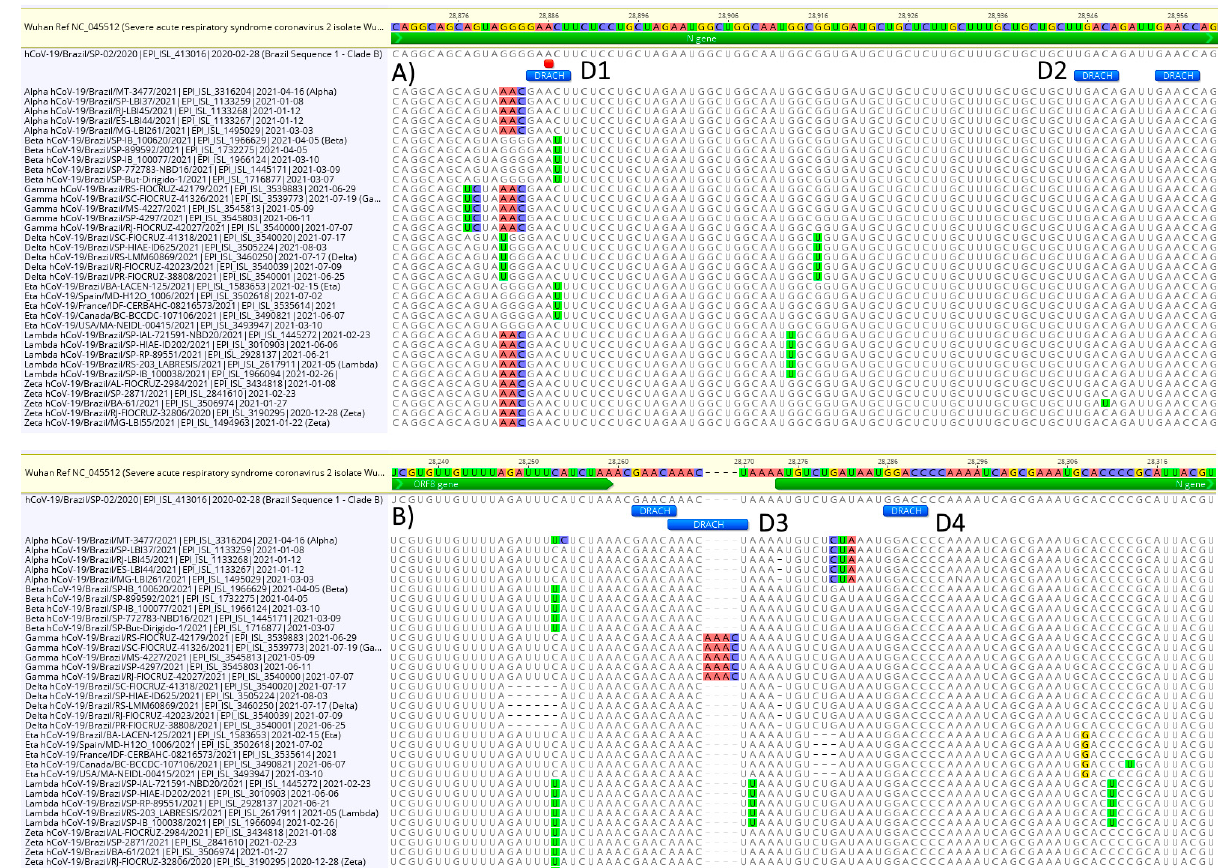
Figure 2. Variability of DRACH sequences among SARS-CoV-2 variants. In ( A ), the C > U change at 28,886 disrupts the m6A (marked red) DRACH motif (D1) in five variant Beta sequences and four variant Eta sequences, while a single variant Zeta has a C > U mutation that disrupts the DRACH motif (D2). In ( B ), a four bases insertion in the intergenic region ORF8/N does not disrupt DRACH (D3), while (D4) shows a fully conserved DRACH.